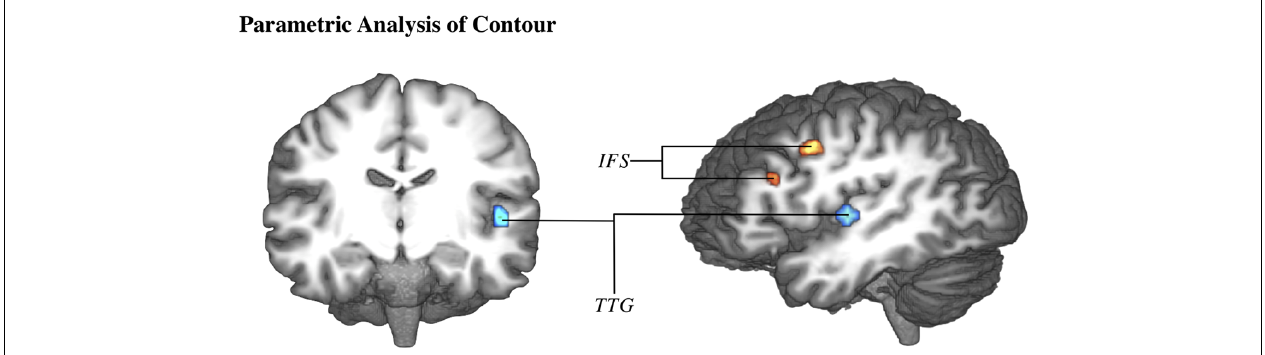
FIGURE 4 | Brain activation correlates of emotion experimental task of study 2 (Drolet etal., 2013). Group-averaged ( n = 18) statistical maps of significantly activated areas for parametric effect of contour (higher contour in blue, lower contour in red). Posterior probability maps with a threshold of